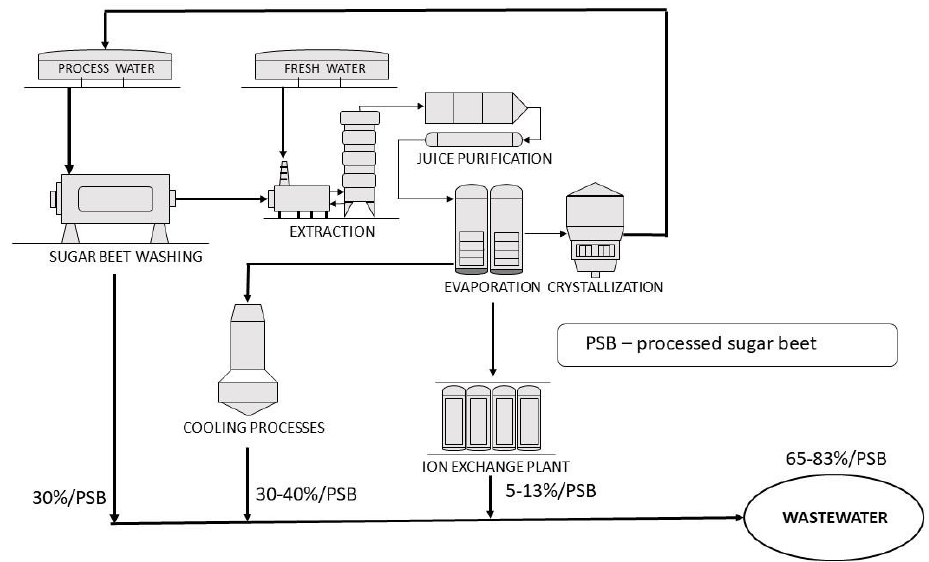
Figure 1. Production scheme of the sugar plant. In the process, each stream with PSB equals to %water per processed sugar beet.